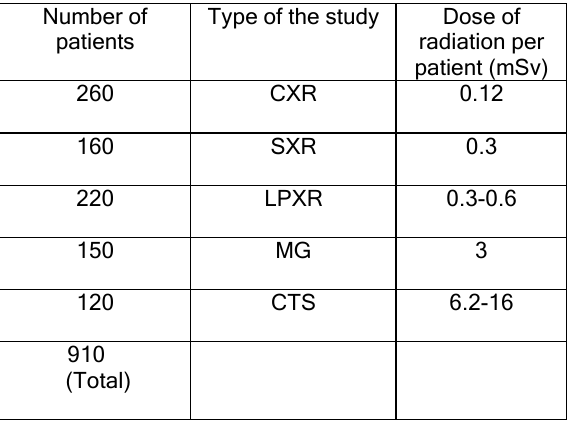
Table-1 No. of patients with type and dose of RDS.